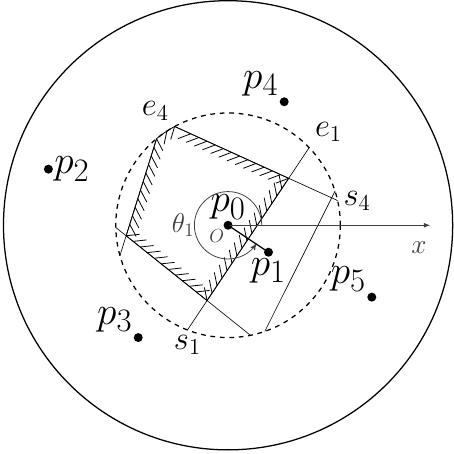
Figure 2. The r /2-limited Voronoi cell of sensor p 0 along with other